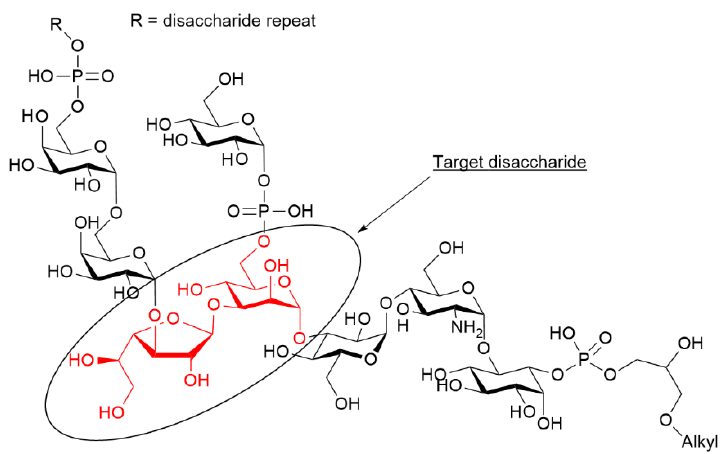
Figure 1. LPG general structure with a special emphasis on the core heptasaccharide and the target disaccharide.